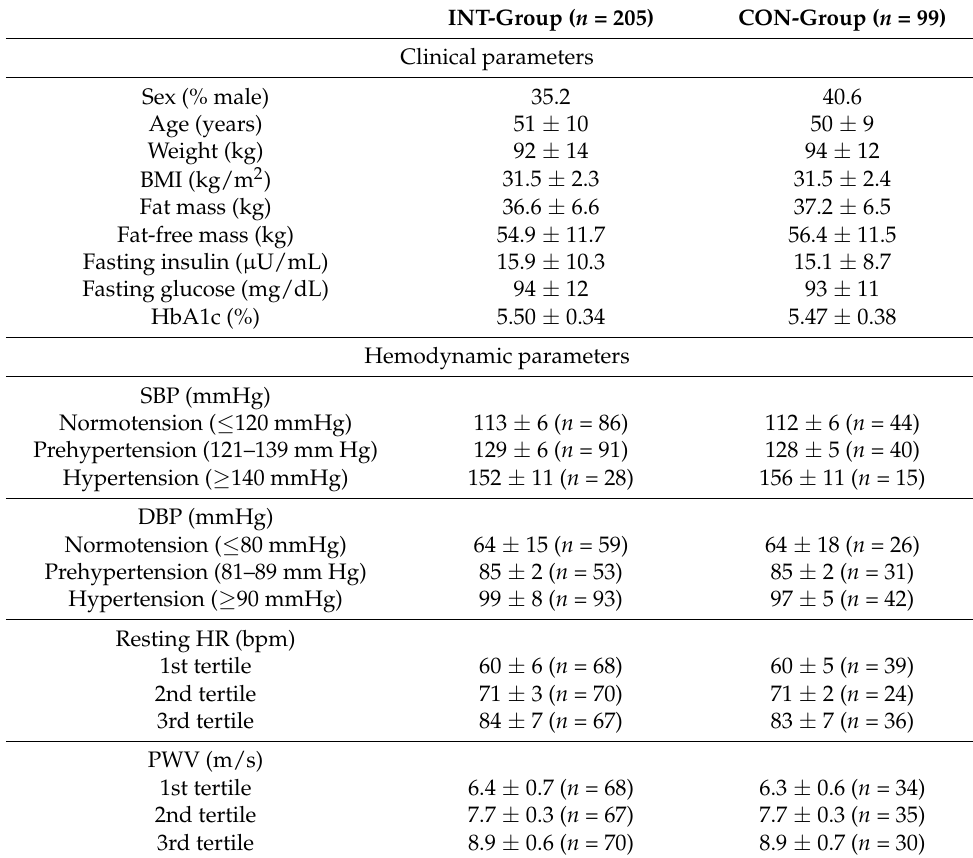
Table 1. Baseline characteristics of the participants completing the whole